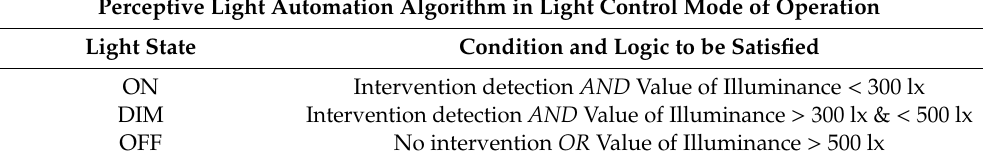
Table 4 by checking two conditions: PIR sensor detection of intervention